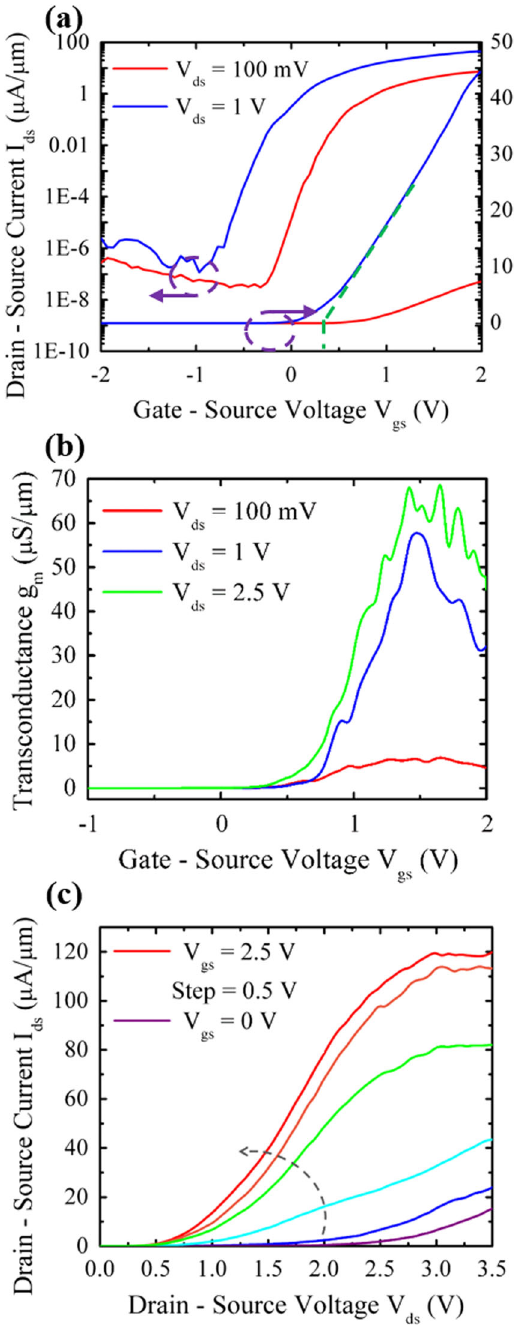
Fig. 2 DC characteristics a Transfer curves, I ds − V gs , for a 150 nm gate length CVD MoS 2 device. The device shows enhancement mode operation with an I ON / I OFF ratio of 10 8 at 100 mV of drain bias. b Transconductance curves, g m − V gs , for the same device. The device has a peak g m of 70 µS/µm at a V ds of 2.5 V. c Output curves, I ds − V ds , for the same device. The device has a current density of 120 µA/µm at a V ds of 3.5 V. The device shows current saturation beyond a V ds of 3 thinning of the Schottky barrier width. The difference in surface charge transfer doping between oxygen-de fi cient HfO 2 − x and stoichiometric Al 2 O 3+ x has been observed and well quanti fi ed in literature. 16 – 18 The elemental composition and chemical stoichio- metry of atomic layer deposition (ALD) alumina were investigated